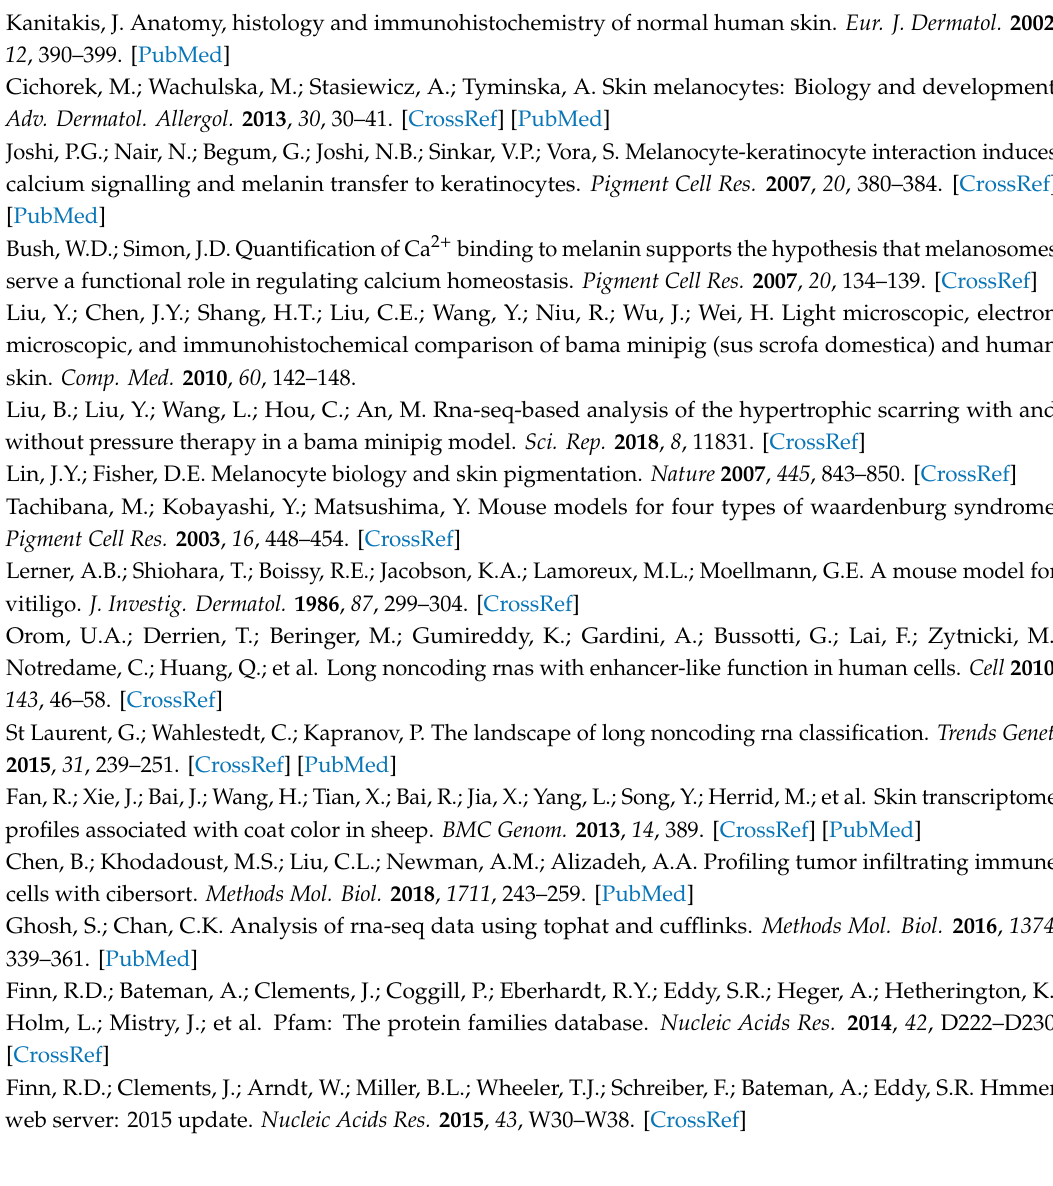
Summary of data information. Table S2: Primer sequences of selected genes. Table S3: Expressed mRNAs. Table S4: Expressed lncRNAs. Table S5: Di ff erentially expressed mRNAs. Table S6: Functional enrichment analysis of DEGs up- or down-regulated in white skin. Table S7: Di ff erentially expressed lncRNAs. Table S8: Functional enrichment analysis of cis target genes. Table S9: Functional enrichment analysis of trans target